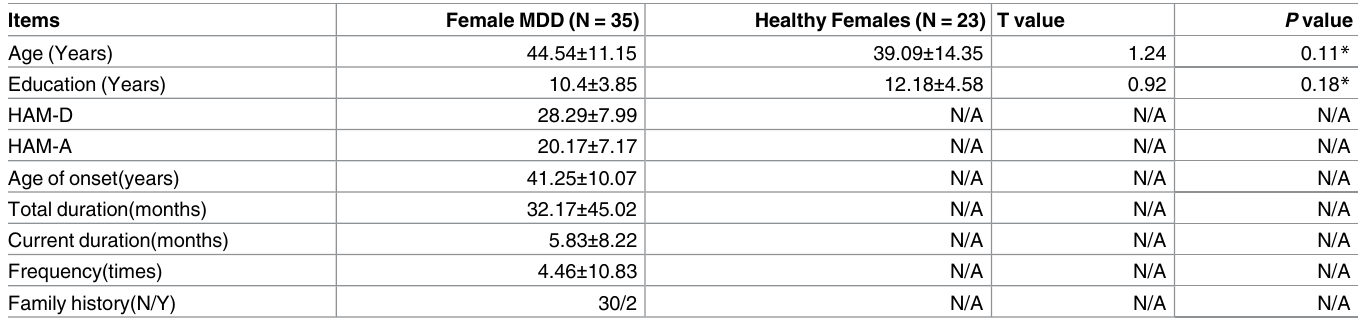
Table 1. Demographic and neuropsychological